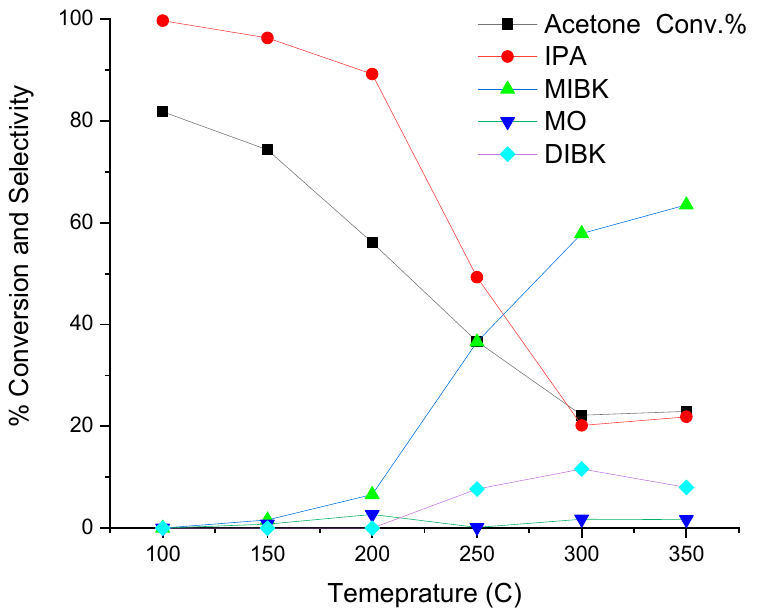
Figure 3. Variation in the conversion of acetone and selectivity at reaction conditions: 0.25 g CAT-IV catalyst, H 2 /DMK mol ratio = 4, TOS = 1-h.